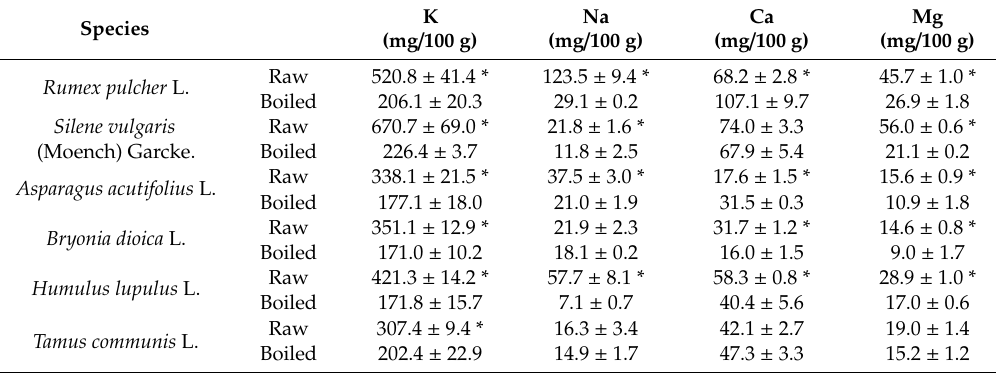
Table 4. Mineral microelements in raw and boiled wild vegetables (mg / 100 g fresh weight). Species Rumex pulcher L. Raw Silene vulgaris (Moench) Garcke.